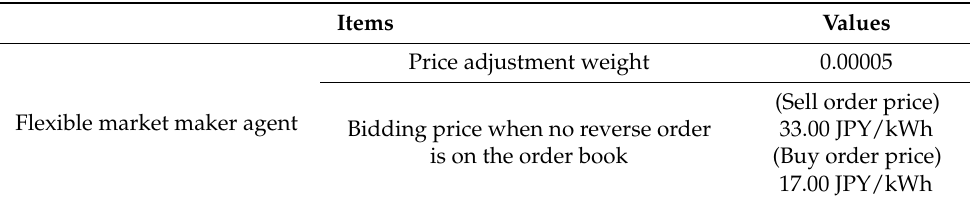
Table 8. Initial parameters in P2P electricity market simulation with the flexible market maker.